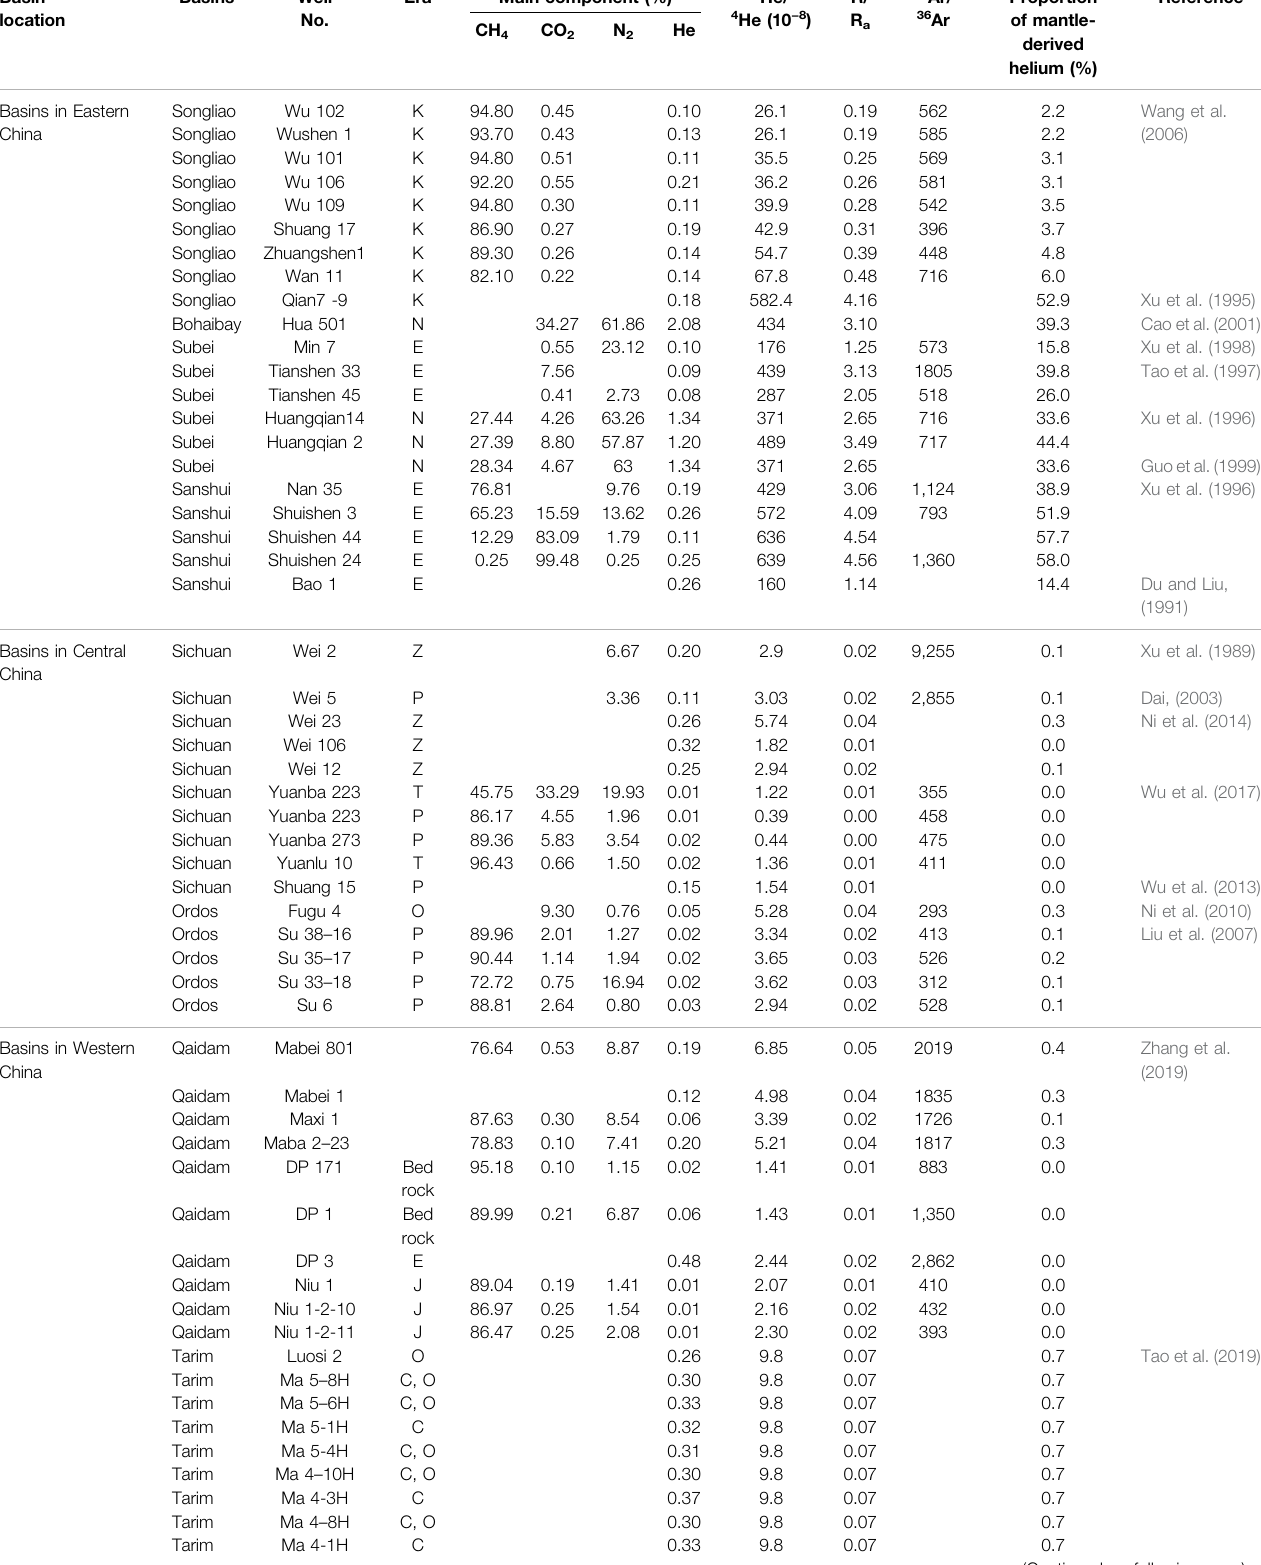
TABLE 1 | Table of samples with helium content in some natural gas from petroliferous basins in China. Basin Basins Well location No.